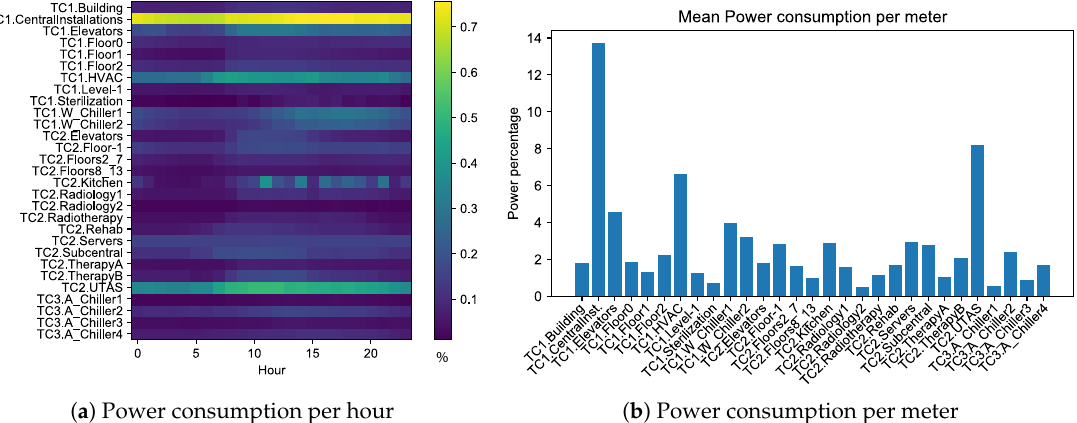
Figure 4. Mean power consumption percentage per hour and per meter, to analyze the contribution of each meter to the whole building